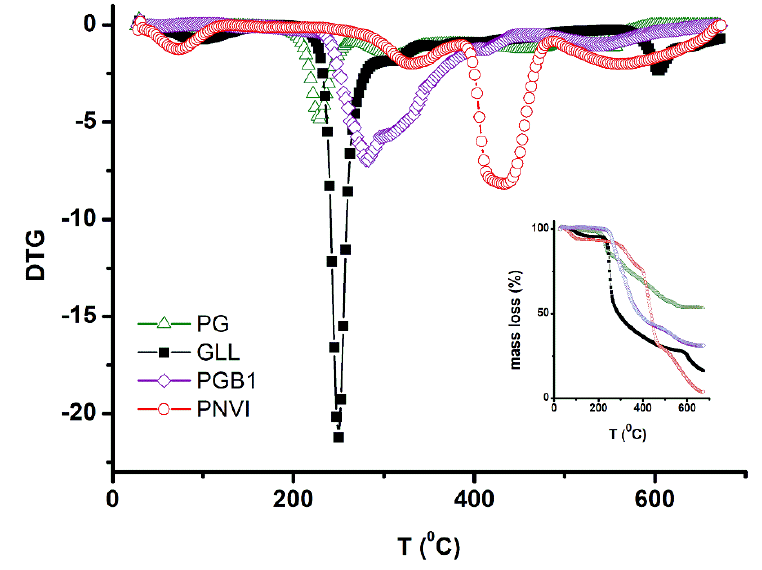
Figure 13. TG and DTG curves of PNVI, GLL, PG and PGB1 samples.